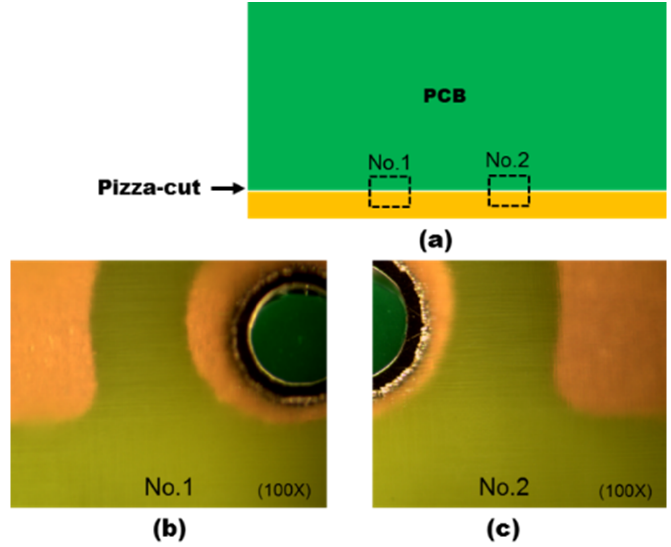
Figure 13. Absence of cracks in a PCB without de-paneling. Observations were performed using an Olympus BX51 microscope at 50× magnification of: ( b ) location No. 1 and ( c ) location No. 2, as marked in ( a ), which is a horizontal cross-section location of a PCB without a de-panel.